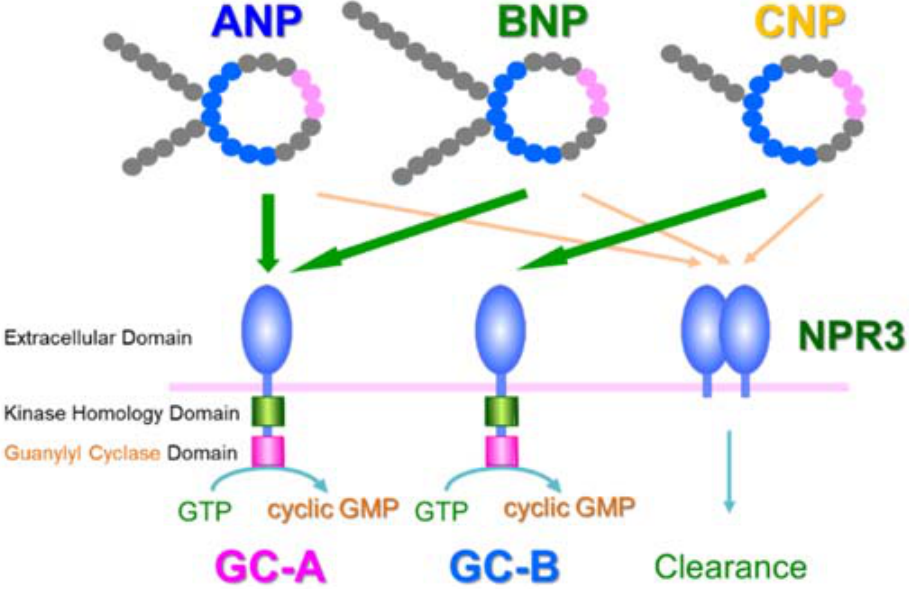
Figure 1. Natriuretic peptides and their receptors. ANP—atrial natriuretic peptide; BNP—brain natriuretic peptide; CNP—C-type natriuretic peptide; GC-A—guanylyl cyclase-A; GC-B—guanylyl cyclase-B; NPR3—natriuretic peptide receptor 3.